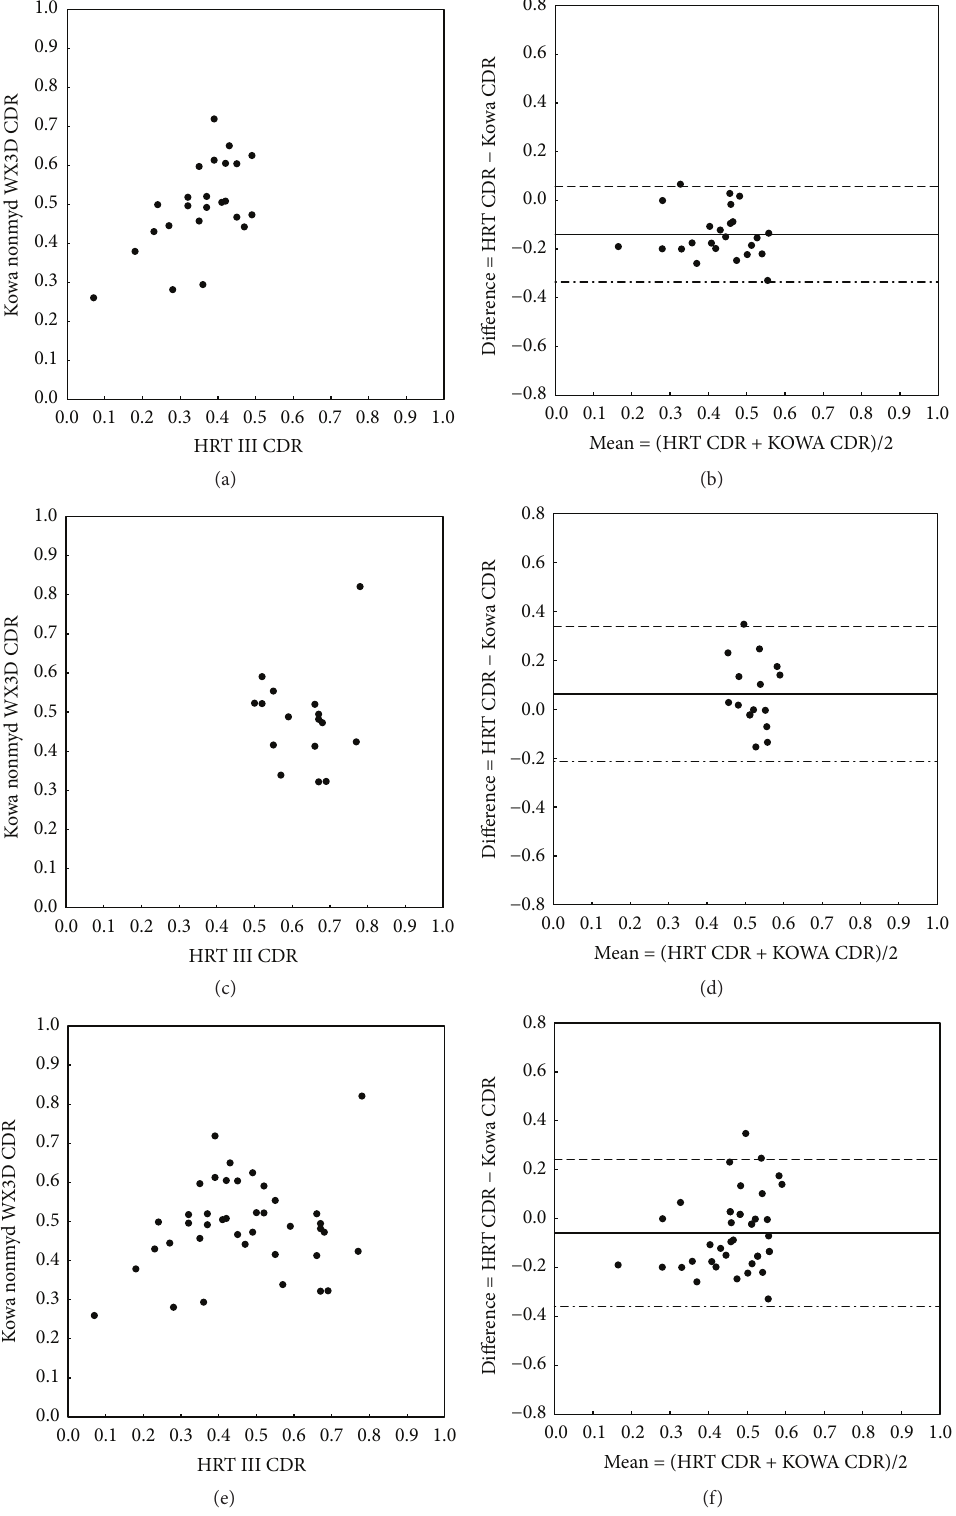
Figure 1: Scatter plots (a, c, e) and Bland-Altman plots (b, d, f) showing the correlation between (vertical) CDR measurements using HRT III versus Kowa nonmyd WX3D, separated for the group with CDR < 0.5 (a, b) and the group with CDR ≥ 0.5 (c, d). Overall comparison is visualized in plots (e, f). In Bland-Altman plots solid lines indicate mean differences between CDR measured with HRT III and Kowa nonmyd WX3D. The 95% limits of agreement are indicated by the upper dashed lines and the lower dot-dashed